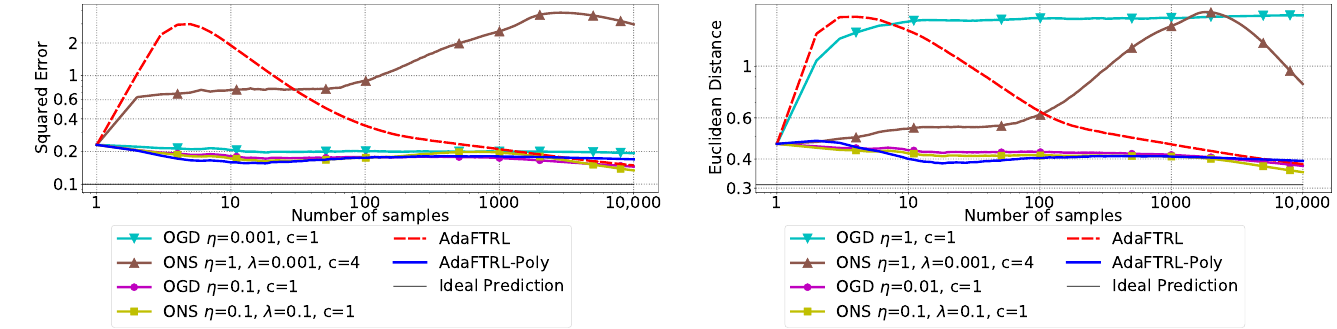
Figure 1. Results for setting 1 (sanity check), using a stationary ARIMA(5,2,1) model.